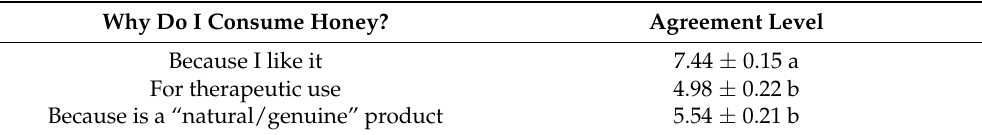
Table 9. Motivational consumption scored on a 9-point scale (1 = disagree completely; 9 = agree completely).